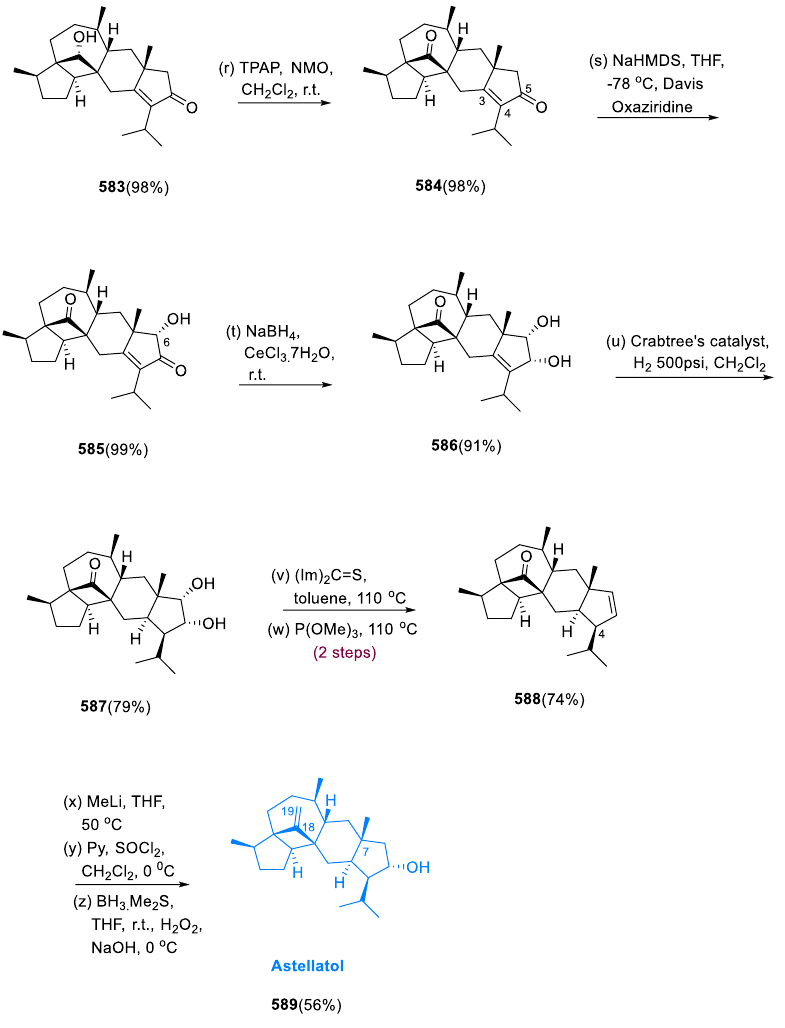
Scheme 34. Total synthesis of